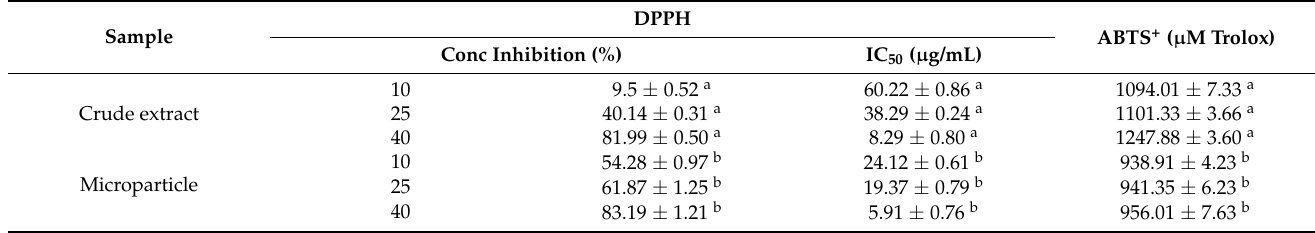
Table 4. Antioxidant activity in the crude extract and microparticle by DPPH and